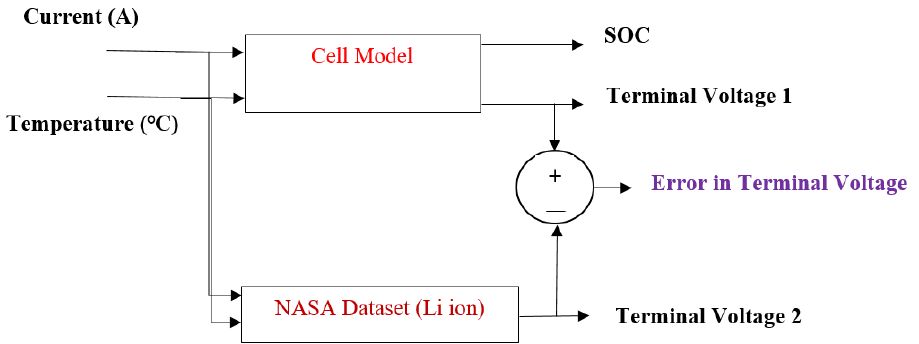
Figure 1. Tuning performed for cell parameter estimation.